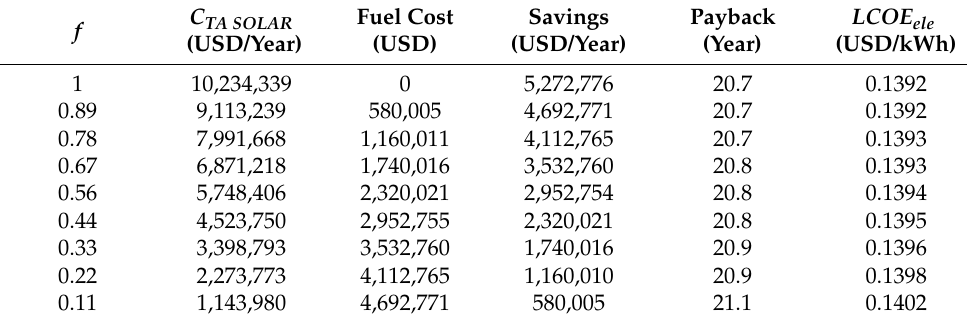
Table 14. Levelised cost of energy for different solar